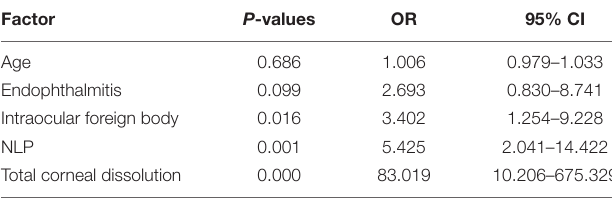
TABLE 4 | Multivariate analysis of the independent risk factors for